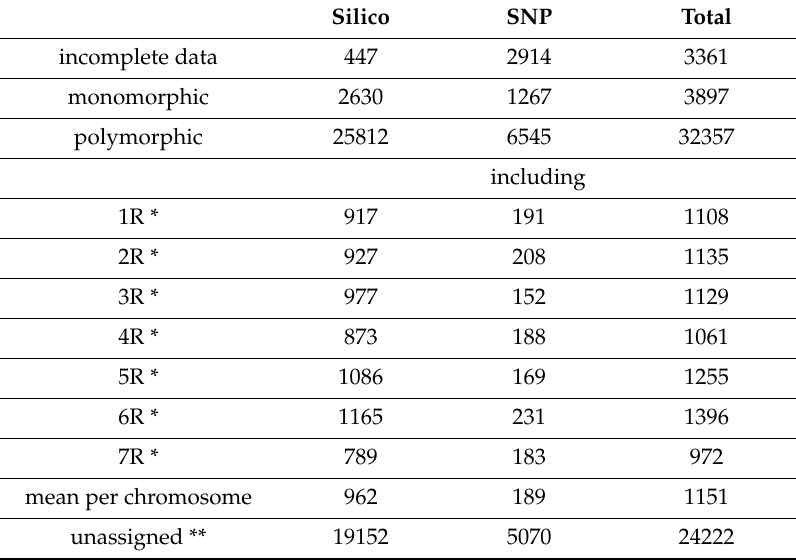
Table 2. DArTseq statistic in rye mapping population BK2-F 2